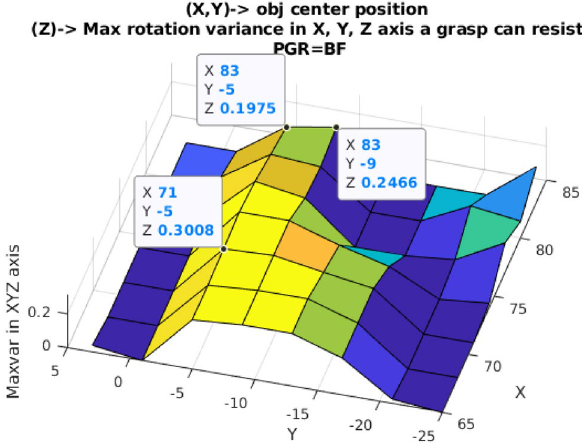
Fig. 17 Maximum rotation variance for each (X,Y) cube